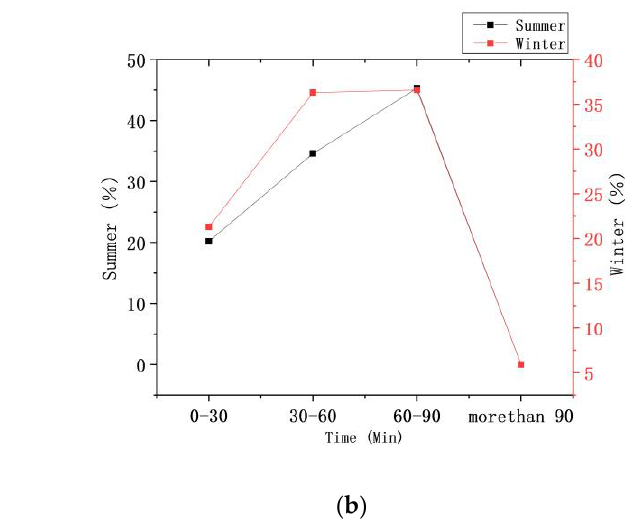
Figure 4. Photo of the present situation of cooking in southern Shaanxi.